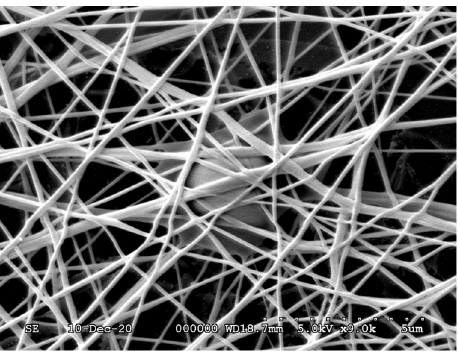
Figure 10. Scanning electron microscopy image of an H 2 sample containing DPSC cells, at 9000 × resolution.